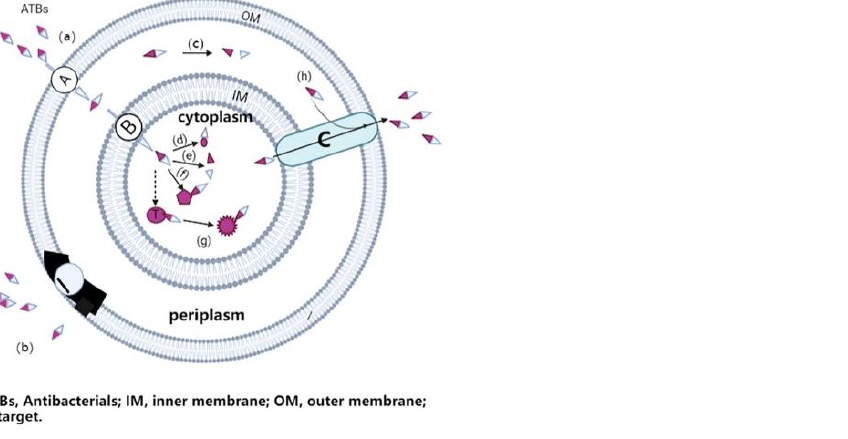
Figure 1. The main resistance mechanisms of gram-negative bacteria to antibiotics. Certain antibiotics have intracellular targets and thus must at least enter the bacterial cell through the pore protein (a) through the outer membrane, and through the inner membrane through the active transport channel (a, b); once the antibiotic enters the bacterial cell, it binds to its target site, disrupt biochemical processes of bacteria, leading to cell growth inhibition or cell death. In the case of antimicrobial resistance, bacteria may develop different evasion strategies, such as reducing the number of pores and transport channels, or changing the structure and function of these membrane proteins to prevent the entry of the antibiotic (b); producing enzymes to destroy or change the chemical structure of ATB molecules in the periplasm or cytoplasm (c, d, e); generating alternative binding sites to prevent vulnerable therapeutic targets (t) from binding to the antibiotic (f); changing the structure and function of the target (f); and developing or upgrading a complex efflux pump (c) to quickly pump the antibiotic out of bacterial cells (h).